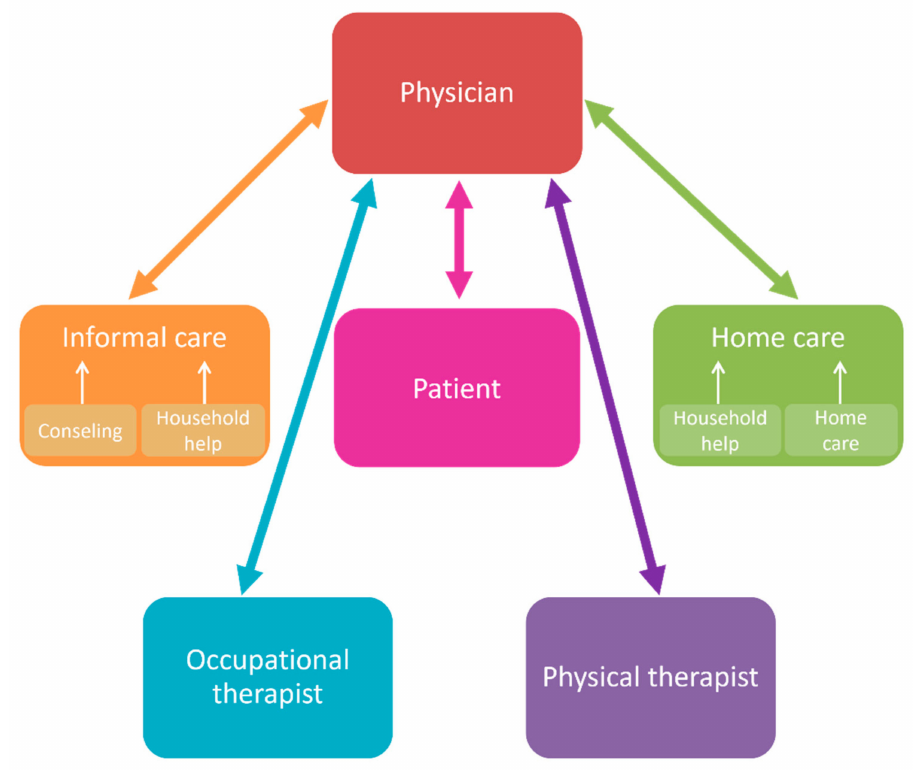
Figure 1. Overview of the health professions involved in the Swiss primary prevention